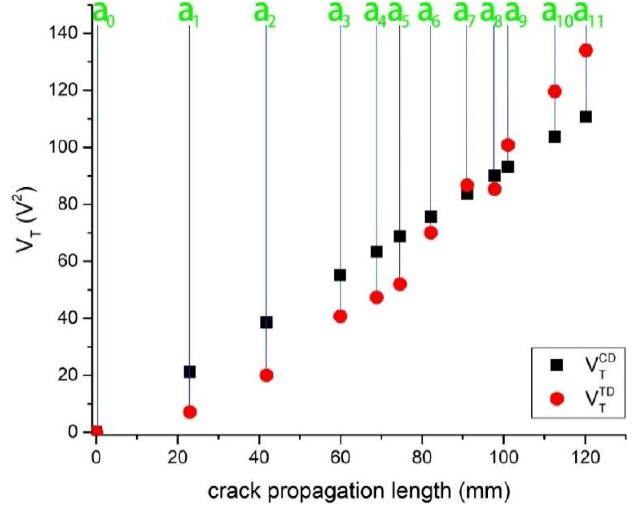
Figure 12. Relationship between the velocity calculated by the model ( 𝑉 𝑇𝑇𝐷 ) and the velocity calculated by the test data ( 𝑉 𝑇𝐶𝐷 ). The correlation coefficient was 0.96.